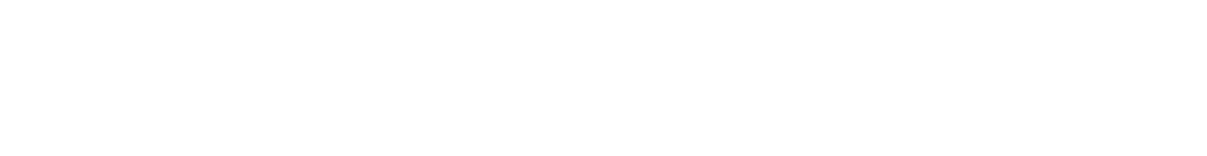
Frontiers in Chemistry |